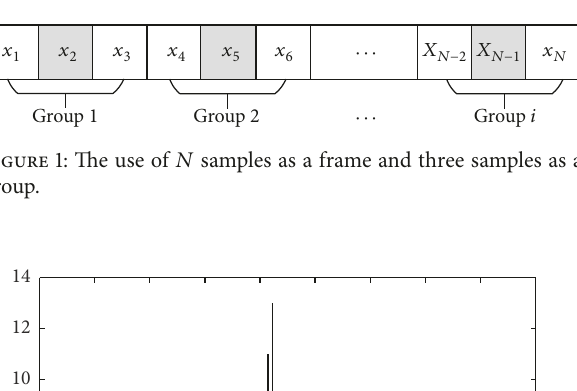
Figure 3: The distribution of the 𝐸 values of track 1 after embedding